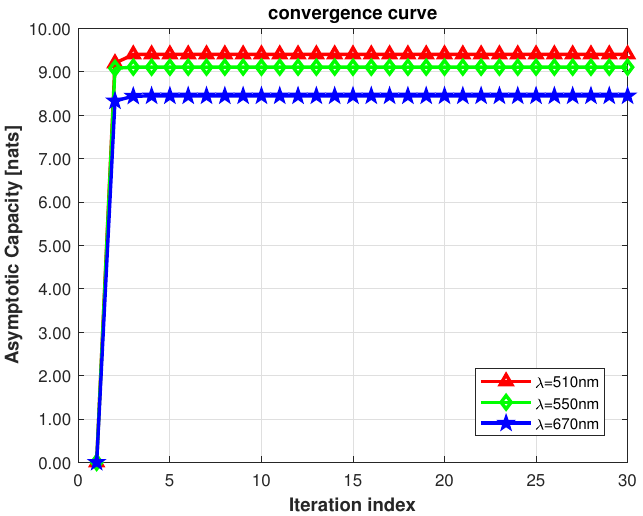
Figure 5. The convergence process of Algorithm 1 with different wavelengths of the light